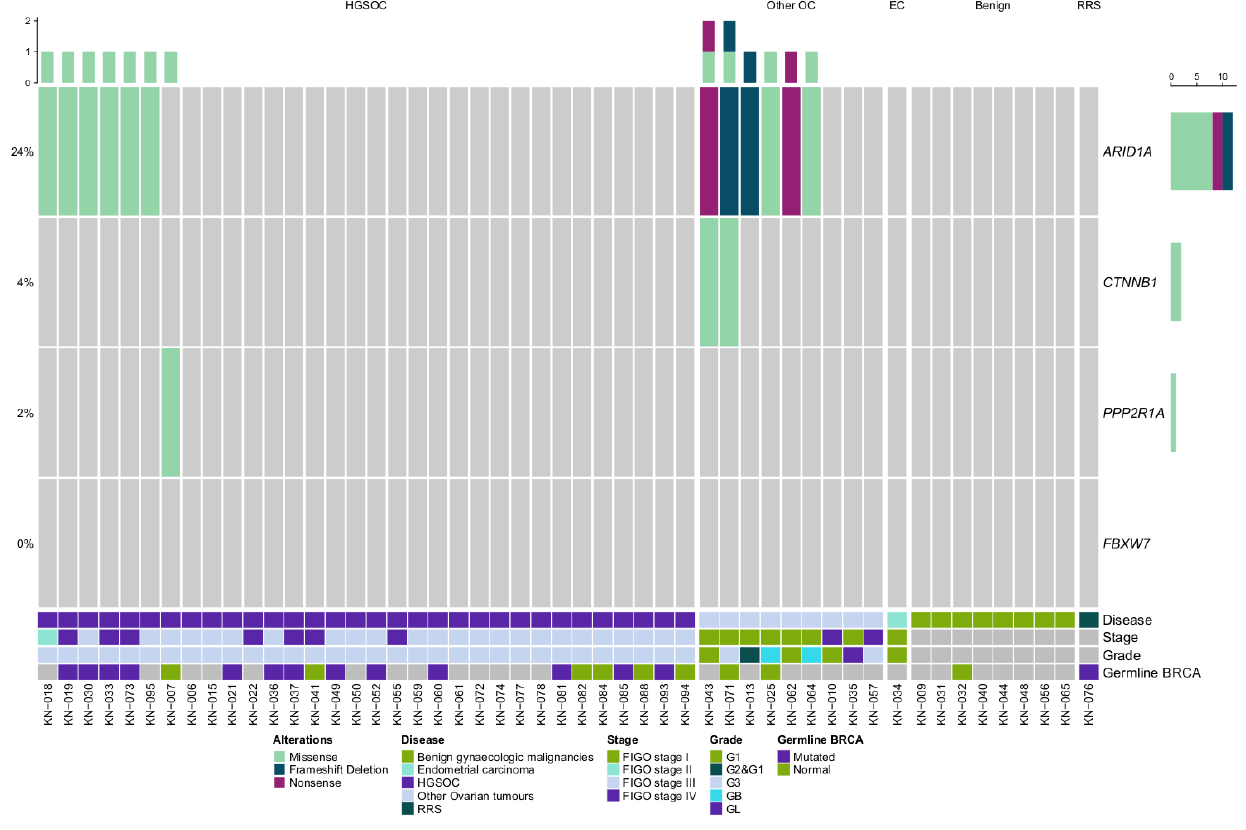
Figure 5. Oncoprint of gynaecologic tumour tissue sample mutation data. HGSOC—High-grade ovarian cancer, OC—ovarian cancer, EC—endometrial cancer, RRS—risk-reducing surgery. Both CTNNB1 alterations were exclusively detected in non-serous type cancer: one in clear-cell OC and the other in a case with simultaneous endometrioid ovarian and endometrial